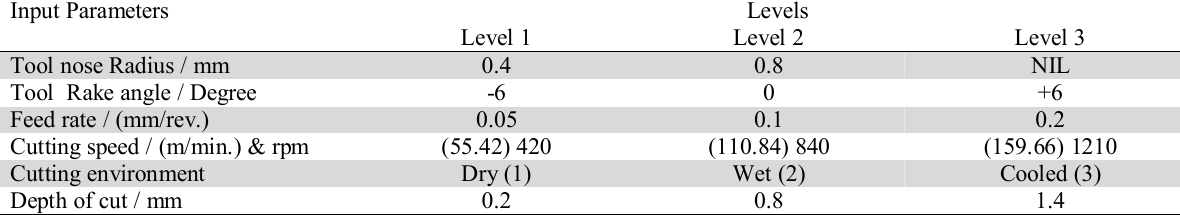
Process Parameters with Different Operating Levels Input Parameters